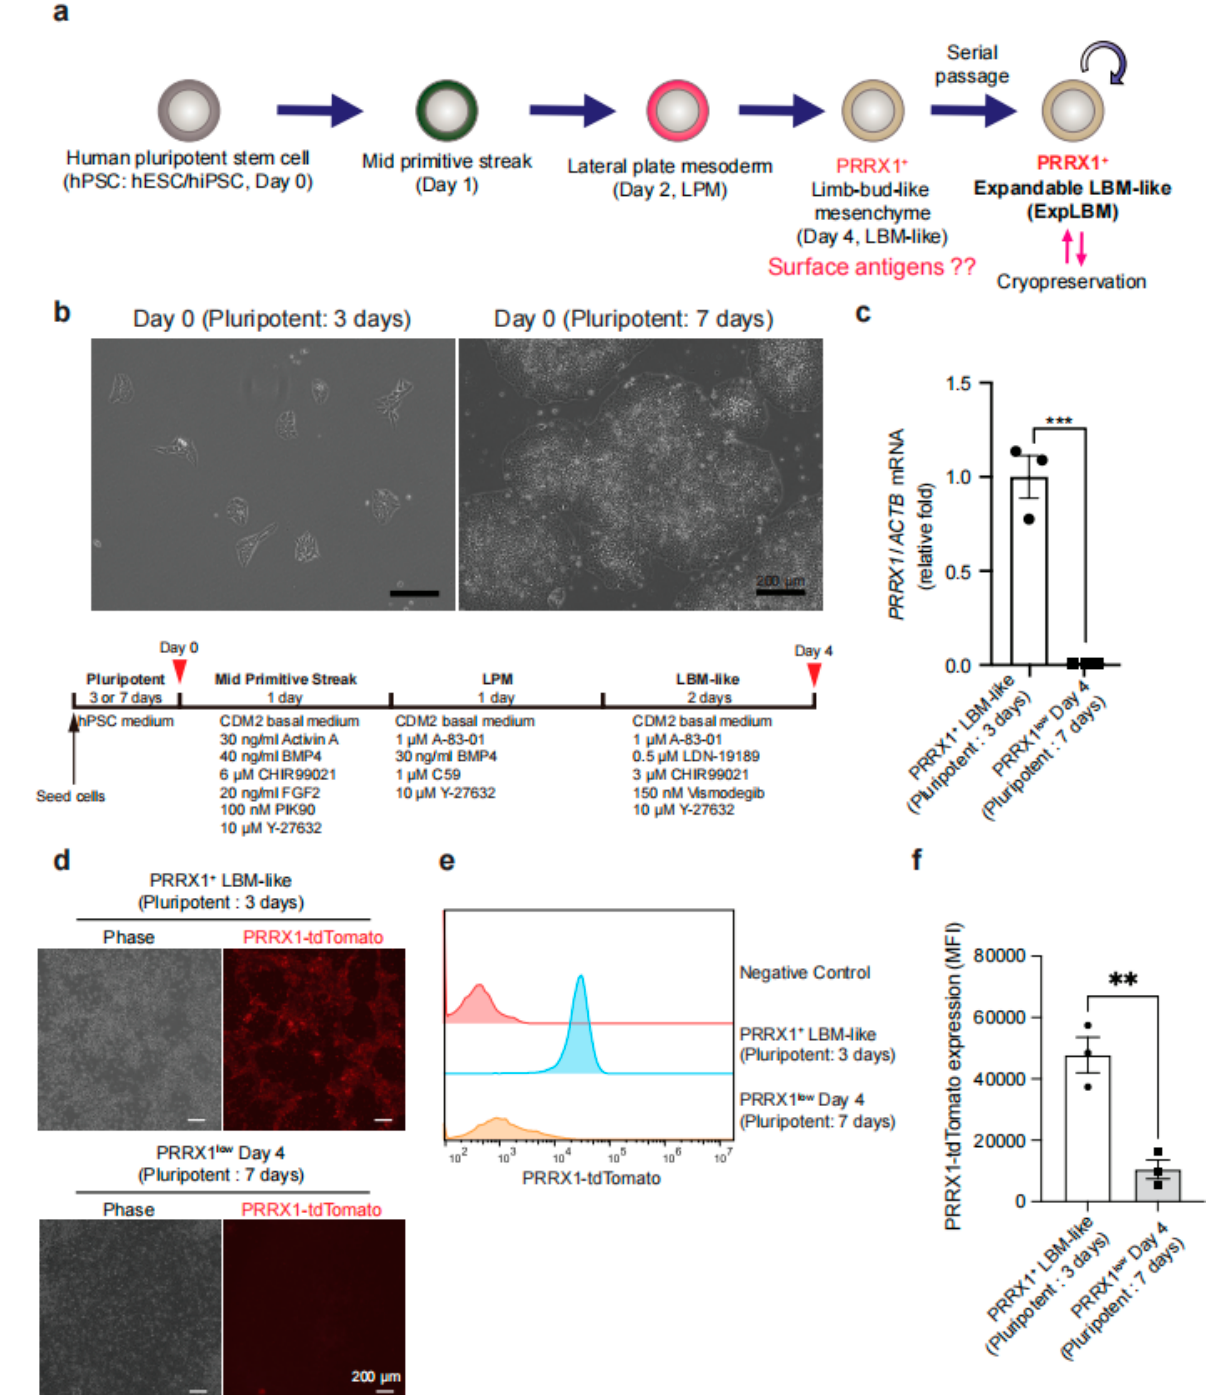
Figure 1. Suppressive effect of high cell density at pluripotent state on inducing PRRX1-tdTomato + LBM-like cells. ( a ) Schematic overview of the induction and stable expansion of hPSC-derived LBM-like cells. ExpLBM with high chondrogenic capacity is assessed by CD90 high CD140B high CD82 low , but surface antigens that define PRRX1 + LBM-like cells have not been identified. ( b ) Phase images at pluripotent state just before LBM-like induction. PRRX1-tdTomato reporter hPSCs were seeded and maintained on culture dishes for 3 or 7 days. Note that cells at Pluripotent: 7 days had high cell